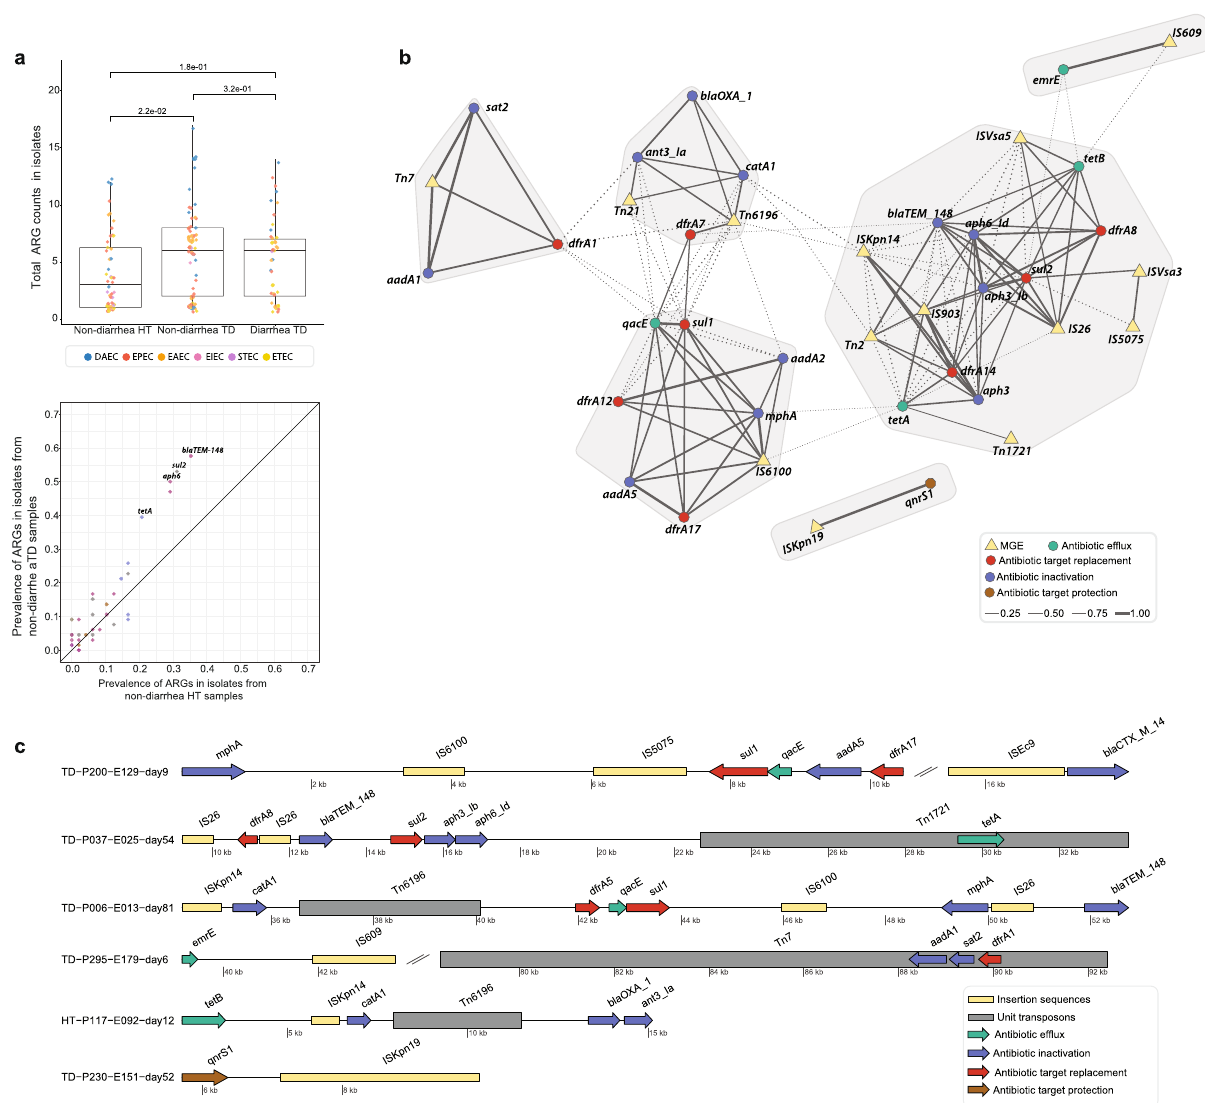
number of unique ARGs carried by DEC strains in non-diarrhea samples of TD subjects compared to HT subjects ( n =189, Wilcoxon test, P <0.05). The colored data points represent different DEC strain. P values are multiple-hypothesis test corrected using Benjamini – Hochberg (FDR) method. Boxes show median and quartiles; error bars extend to the values within 1.5 interquartile range. Dotplot at the bottom shows the prevalence of ARGs in DEC isolates obtained from non- diarrheal HT and non-diarrheal TD subjects ’ samples. The annotated